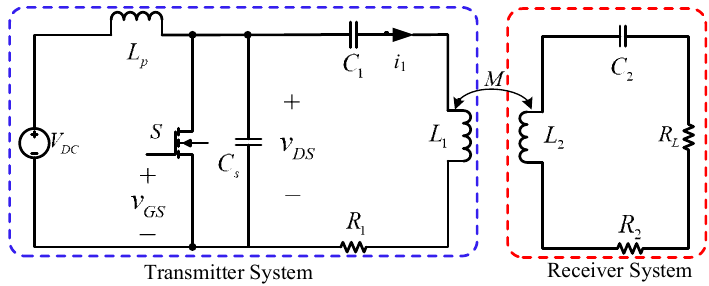
Figure 1. Schematic diagram of Class-E inverter used in wireless power transfer (WPT) system.